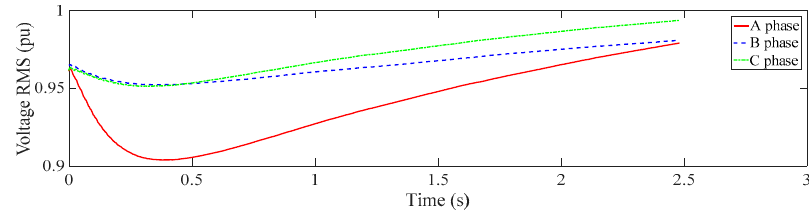
Figure 4. Typical voltage RMS waveform of a motor starting.